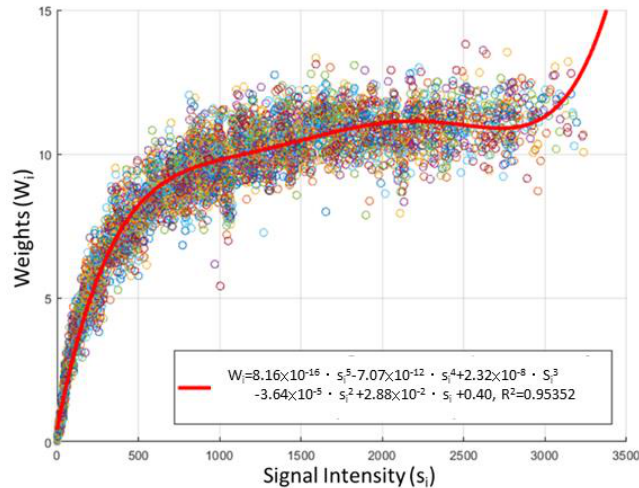
Figure 9. The relationship between signal intensity ( 𝑠 𝑖 ) and weights ( 𝑤 𝑖 ): the red curve represents the proposed and implemented method for the MRC weights where 𝑤 𝑖 = 8.16 × 10 −16 ∙ 𝑠 𝑖5 − 7.07 ×